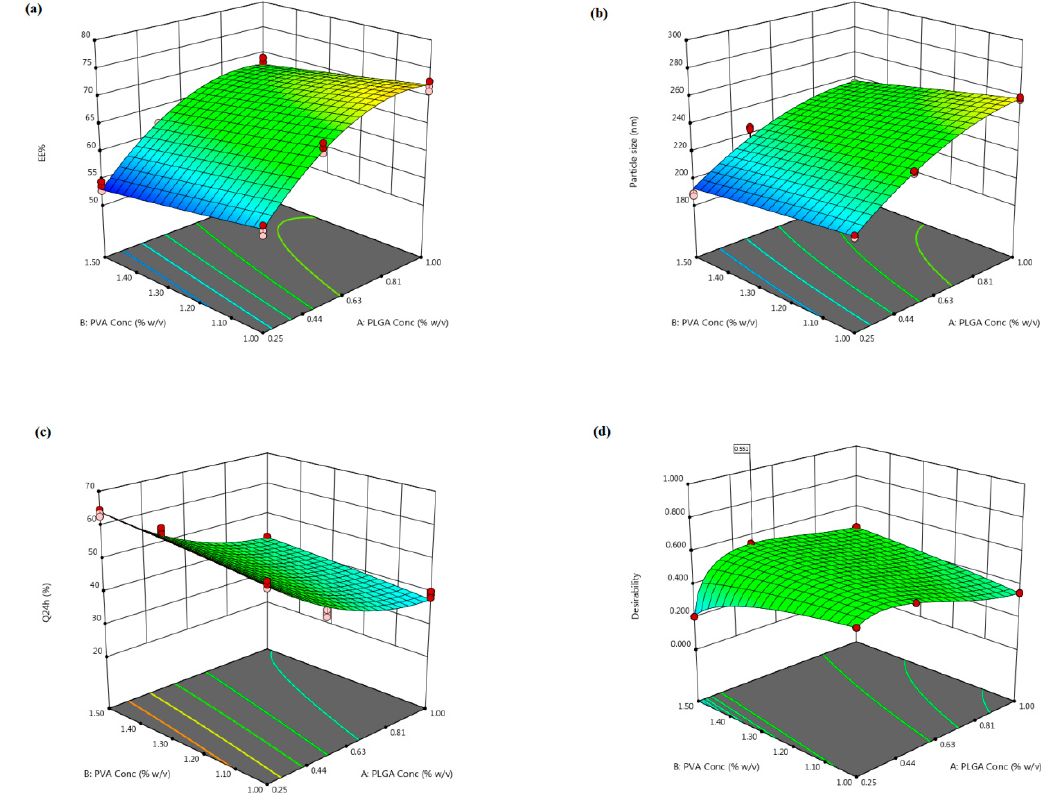
Figure 1. The three-dimensional plot depicting the response surface to the impact of PLGA ( X 1 ) and PVA ( X 2 ) concentrations on ( a ) NFD EE% ( Y 1 ), ( b ) nanocomposites particle size ( Y 2 ), ( c ) Q 24 h ( Y 3 ) as well as ( d ) desirability of the tailored nanocomposites.